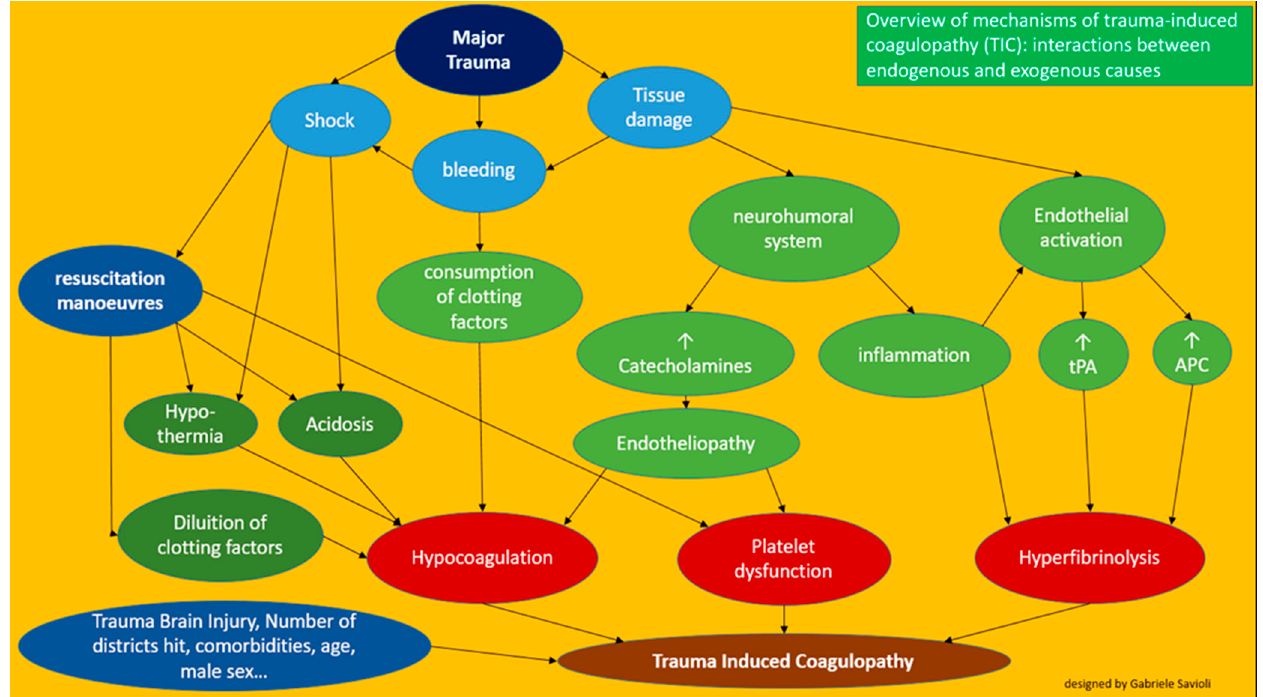
Figure 5. Overview of the mechanisms of trauma-induced coagulopathy